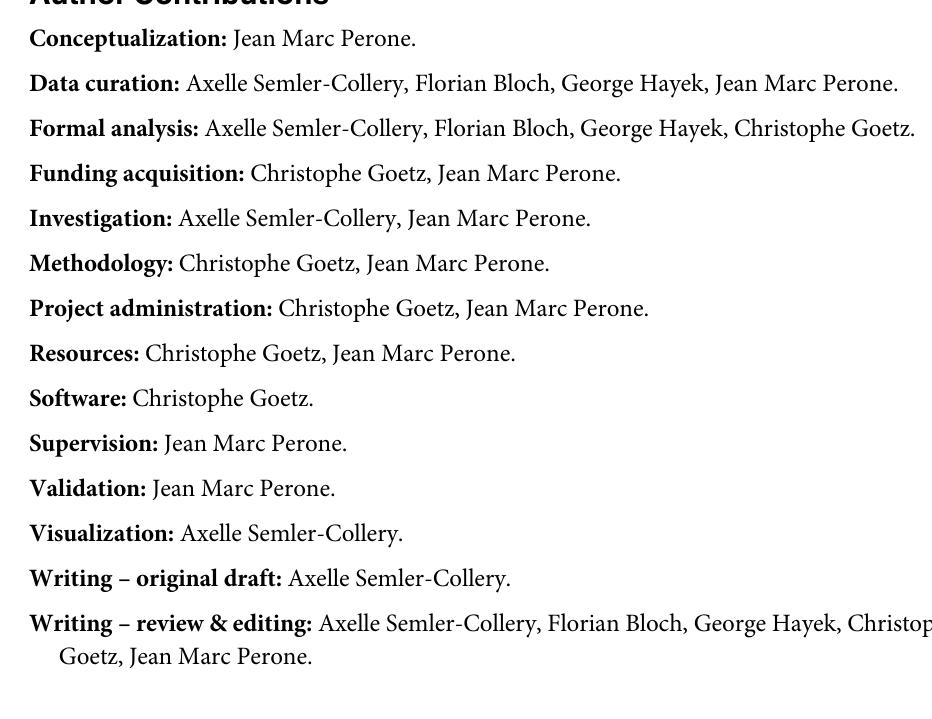
S1 Table. Characteristics of the patient cohorts in the